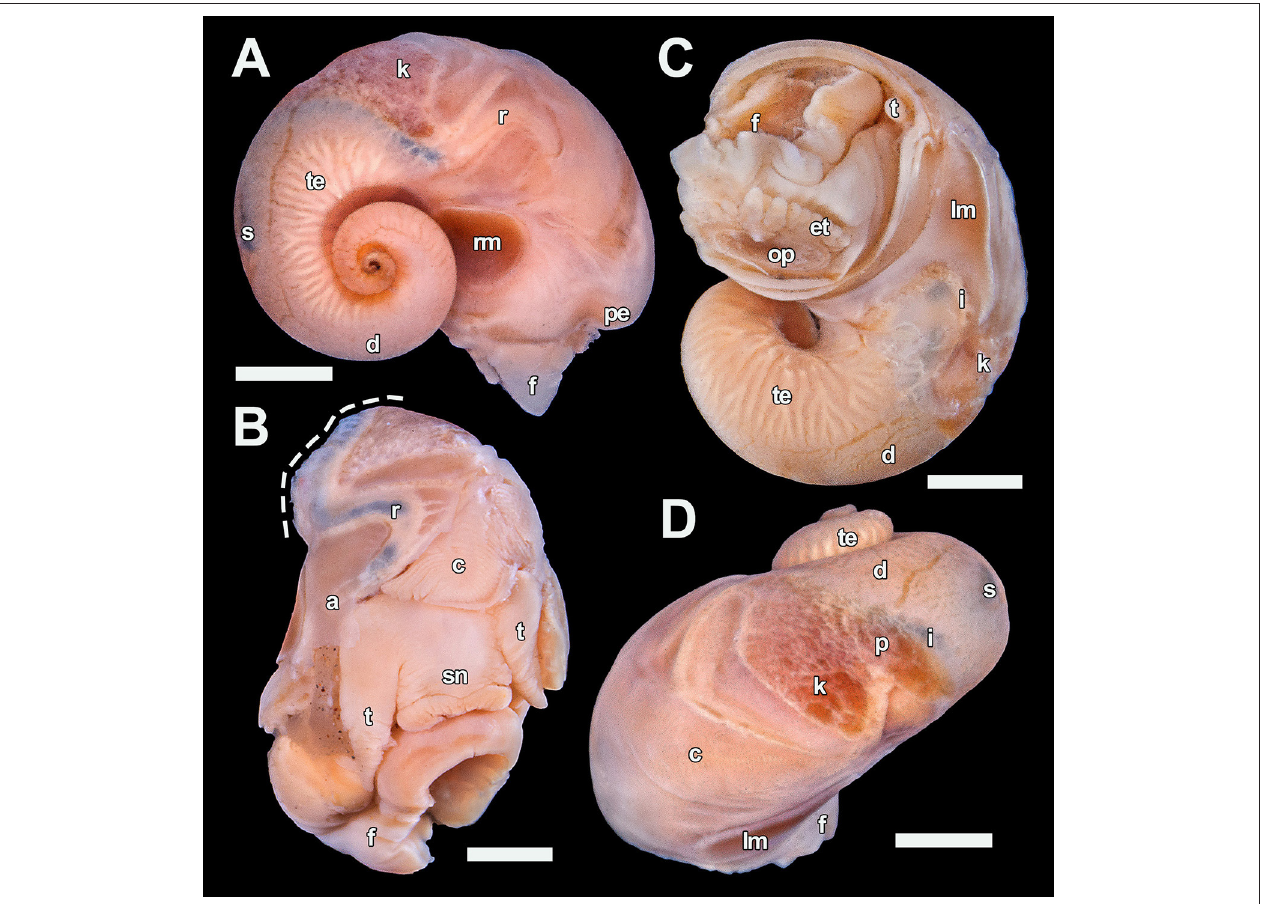
FIGURE 7 | Dracogyra subfuscus n. gen., n. sp. soft parts, paratype 5 (UMUT RM32668). (A) Right view, (B) Anterior view with part of the mantle roof removed to expose the ctenidium (visceral mass cut away at dashed line), (C) Ventral view, (D) Dorsal view. Scale bars: (A), (C–D) = 1mm, (B) 0.5mm. a, anus; c, ctenidium; d, digestive gland; et, epipodial tentacle; f, foot; i, intestine; k, right kidney; lm, left columellar muscle; op, opercular attachment; p, pericardium; pe, pallial edge; r, rectum; rm, right columellar muscle; s, stomach; sn, snout; t, cephalic tentacle; te,